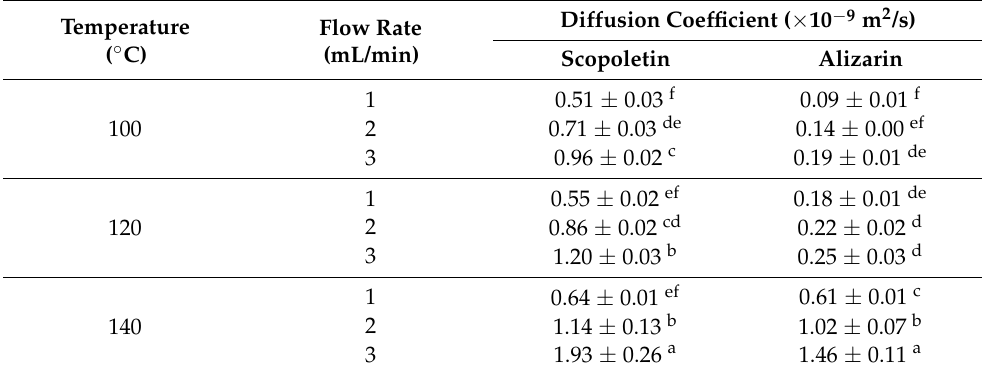
Table 3. Diffusion coefficients of scopoletin and alizarin at various water temperatures and flow rates.